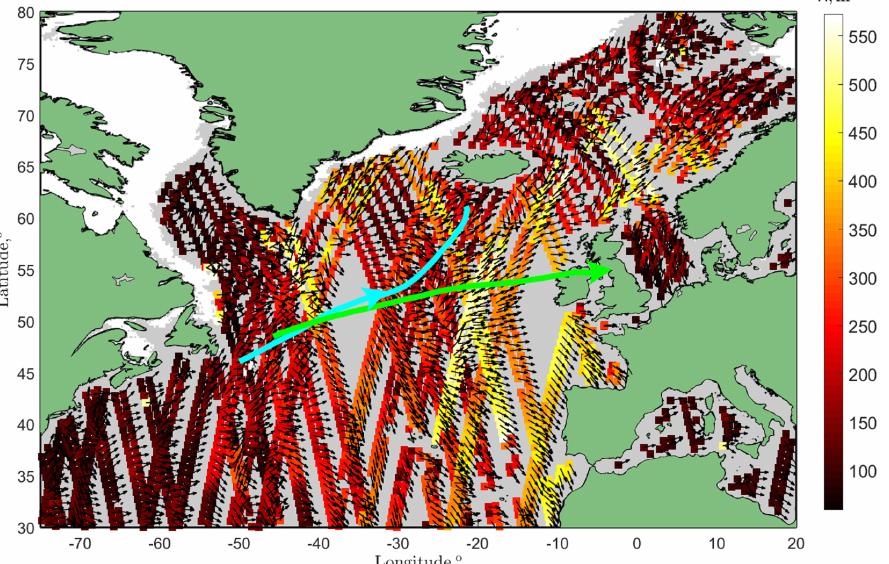
Figure 4. Measured λ p (colored boxes) and ϕ p after eliminating 180° ambiguity (black arrows) in “wave boxes” on two sides of the CFOSAT-SWIM track in Northern Atlantic during the period of 11 February 2020 00:00 UTC —16 February 2020 00:00 UTC, after applying ice and land masks. The green and cyan colored lines and arrows show the trajectory and direction of the ETC#1 and ETC#2,